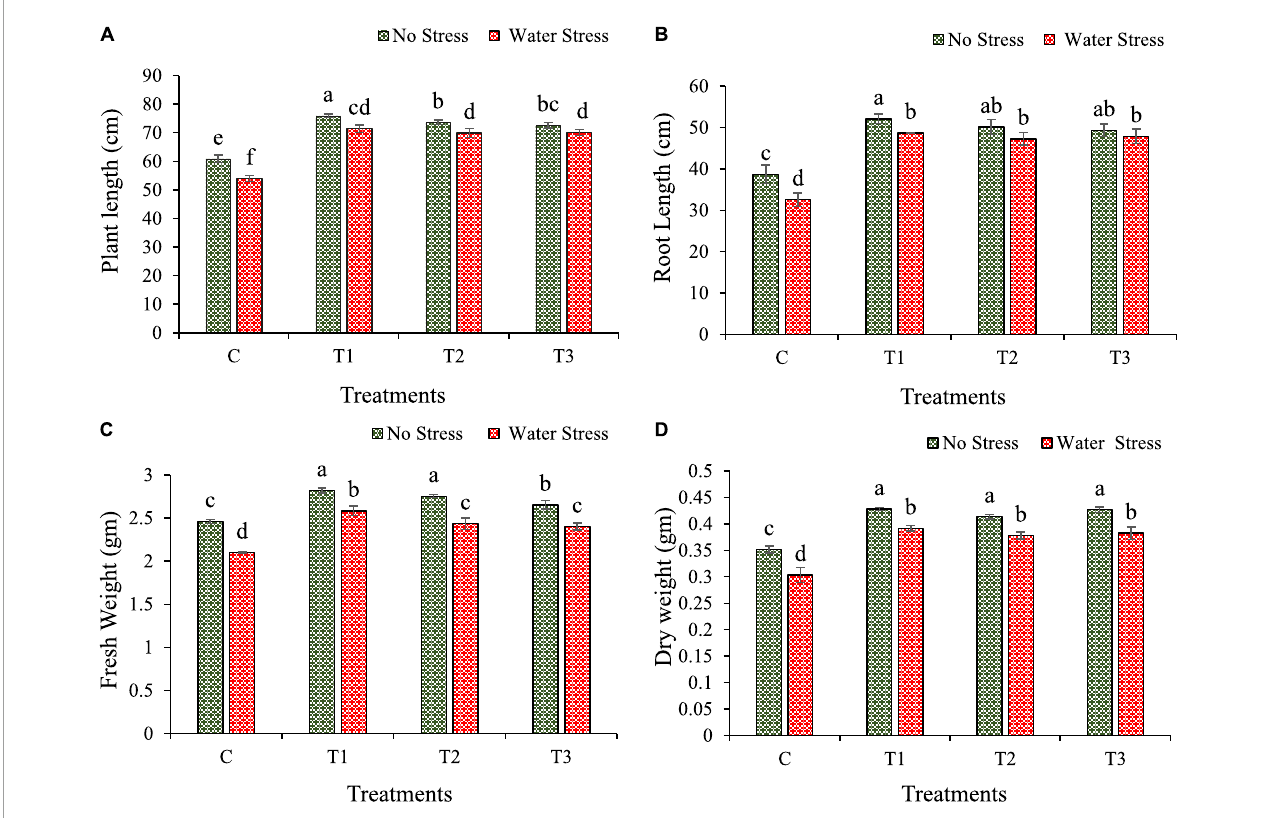
FIGURE4 Impacts of bacterial treatments (T1 — Enterobacter cloacae BHUAS1, T2– Bacillus megaterium BHUIESDAS3, and T3 — Bacillus cereus BHUAS2) on various morpho-physiological features of wheat plants under the influence of water-induced drought stress (A) plant height, (B) root length, (C) fresh weight, and (D) dry weight. Data are presented as means ± SD of three replicates. The different alphabets indicate statistically significant differences between each treatment (DMRT p < 0.05).